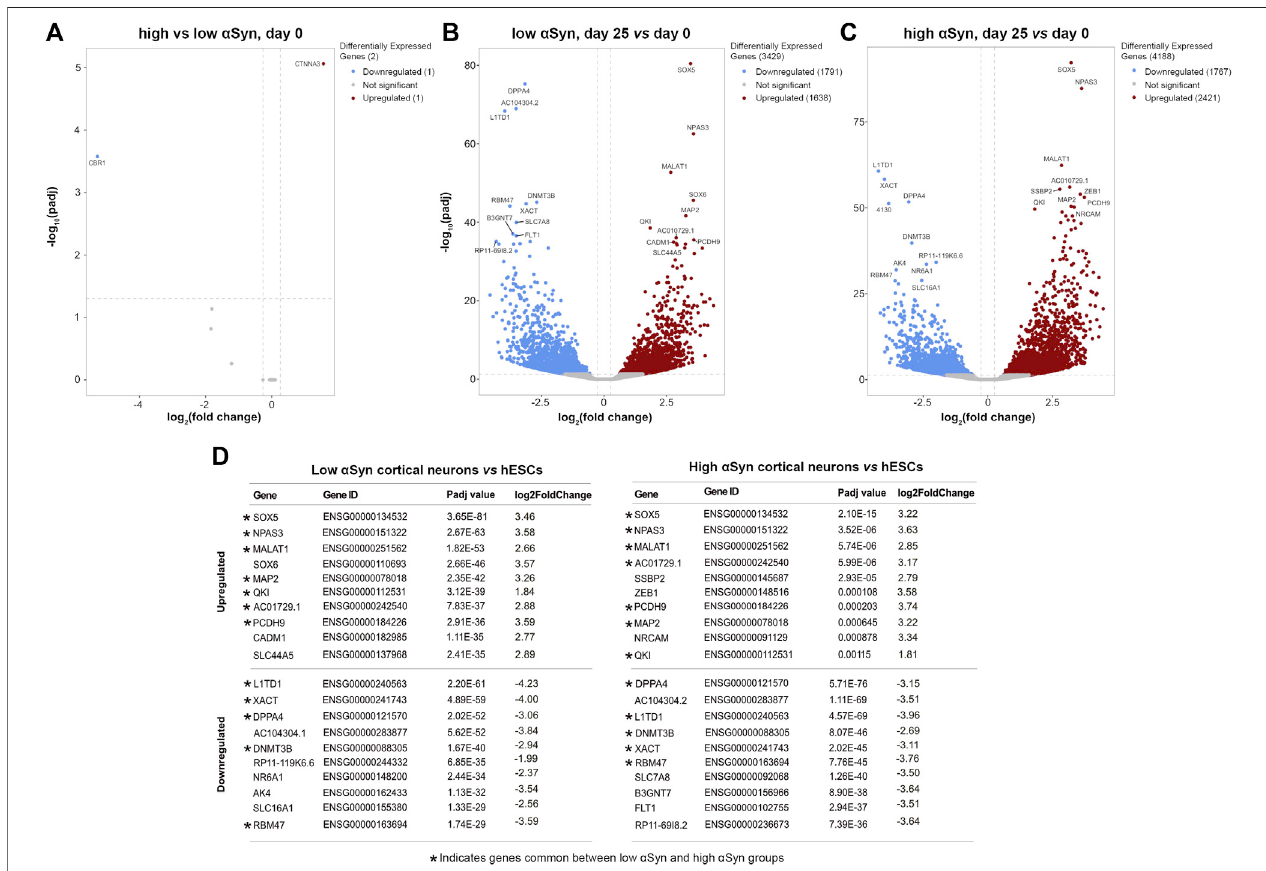
FIGURE 6 | RNA-seq reveals large and over-lapping gene expression changes between cortical neurons and hESCs for both low α Syn and high α Syn groups. (A – C) Volcanoplotsshowingdifferentiallyexpressedgenesbetween (A) low α SynhESCsandhigh α SynhESCs, (B) low α Syncorticalneurons(day25) vs hESCs(day0), and (C) high α Syn cortical neurons (day 25) vs . hESCs (day 0). Horizontal dashed lines cross the y -axis at – log 10 (0.05), representing a signi fi cance cut-off Padj value of 0.05. Vertical lines represent a fold-change cut-off of 1.2, and therefore cross the x -axis at 0.263 and − 0.263.